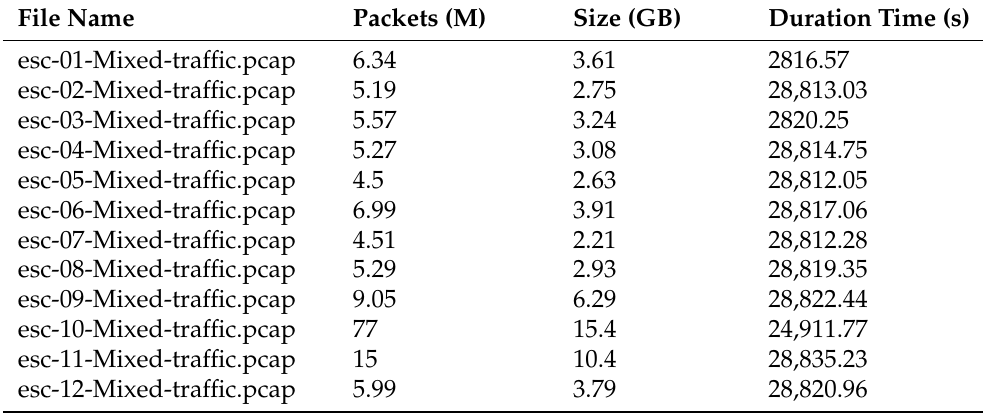
Table 3. Summary of the UAN-12 dataset.